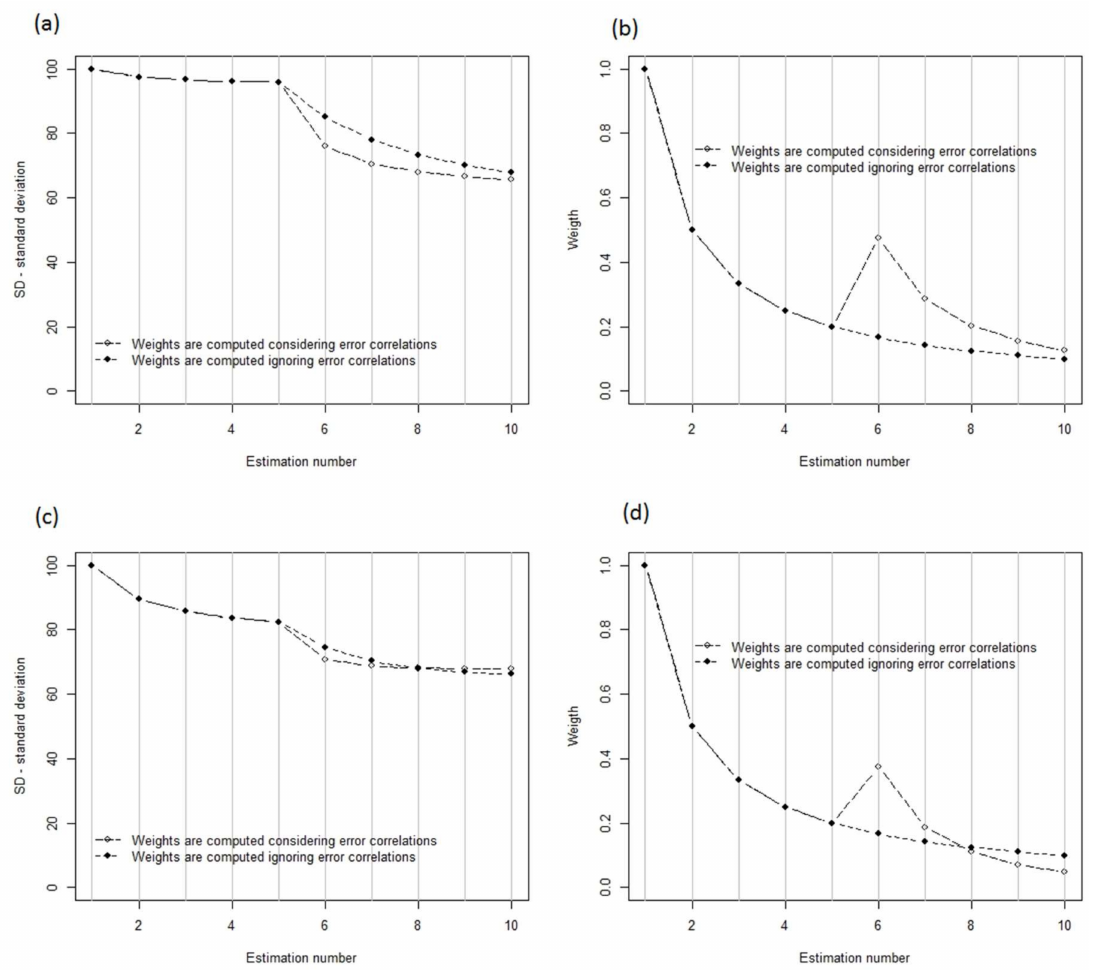
Figure 4. Demonstration of Case B in terms of true relative standard deviation on the left side panels ( a ) and ( c ), and corresponding weights on the right side panels ( b ) and ( d ); for subcase (1) where five estimates with error correlation 0.9 are followed by five estimates with error correlation 0.4 (( a ) and ( b )); and subcase (2) where five estimates with error correlation 0.6 is followed by five estimates with the same error correlation 0.6 (( c ) and ( d